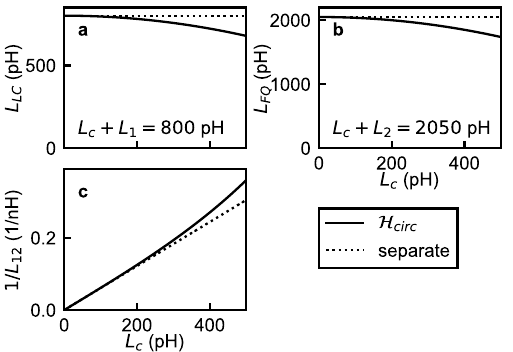
Figure 2. ( a ) The inductances of the LC oscillator L LC , ( b ) the inductance of the flux qubit L FQ , and ( c ) the inverse inductance of ˆ H 12 , 1 / L 12 obtained by Eqs. (9), (10), and (3) (solid lines) are plotted as functions of L c together with their counterparts in the separate treatment (dotted lines) on condition that the inductance sums 800 pH and L 2050 L 1 are kept constant at L c c + L 2 = + =